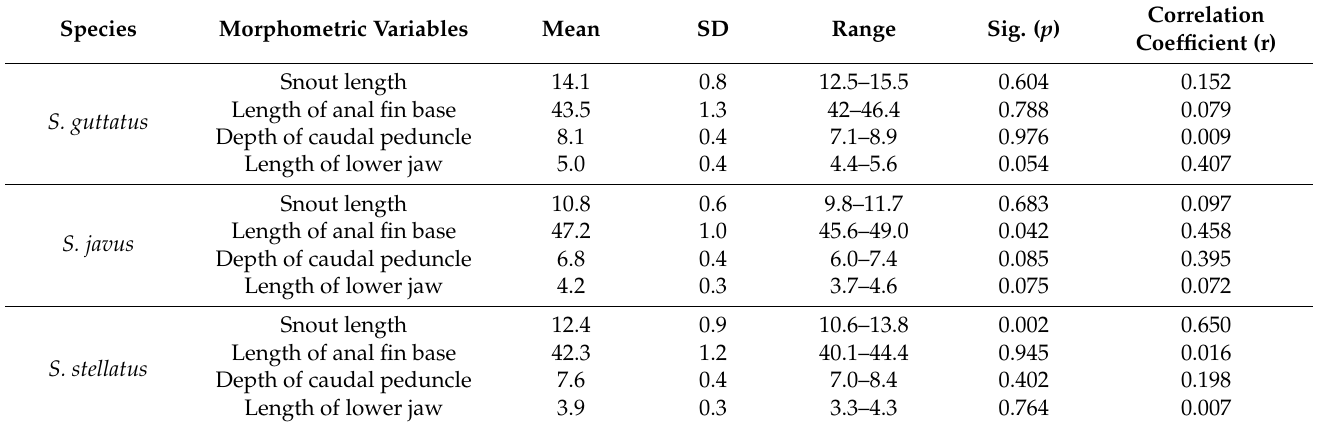
Table 1. Morphometric measurements (as % of standard length) for discrimination of three deep-bodied species collected from the South China Sea, Terengganu,